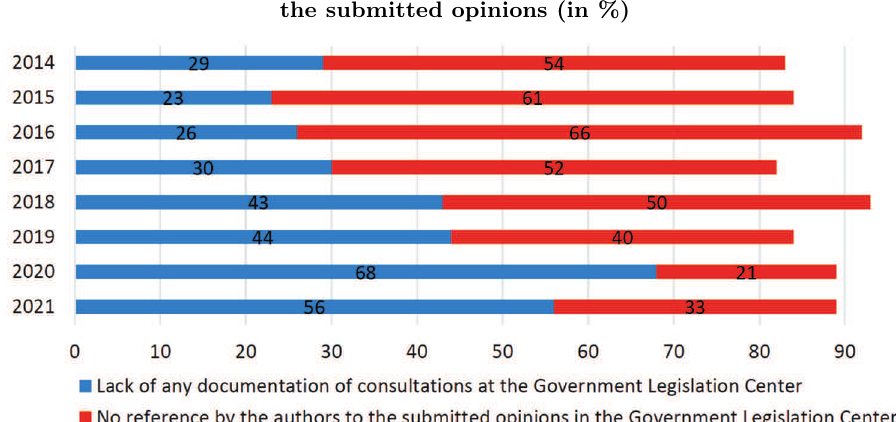
Percentage of draft laws in Poland for which there is no documented public consultation and for which the drafters did not address the submitted opinions (in